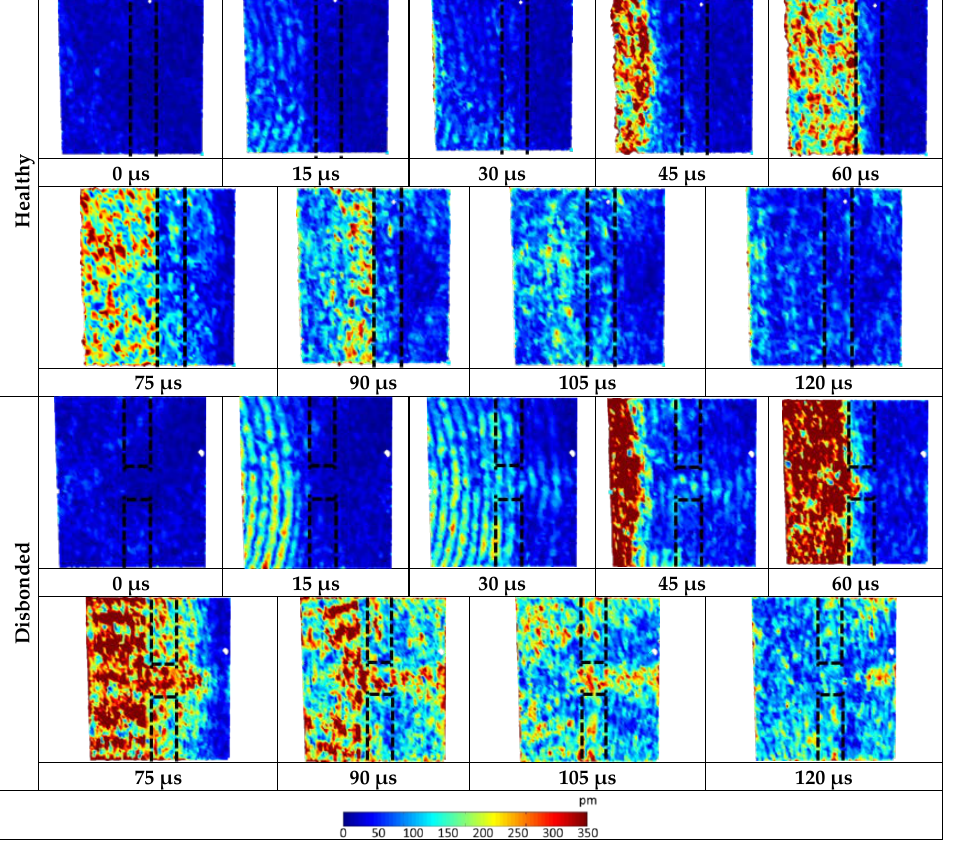
Figure 7. 250 kHz three-component displacement magnitude showing Lamb wave interaction with the healthy disbonded stiffened panel.